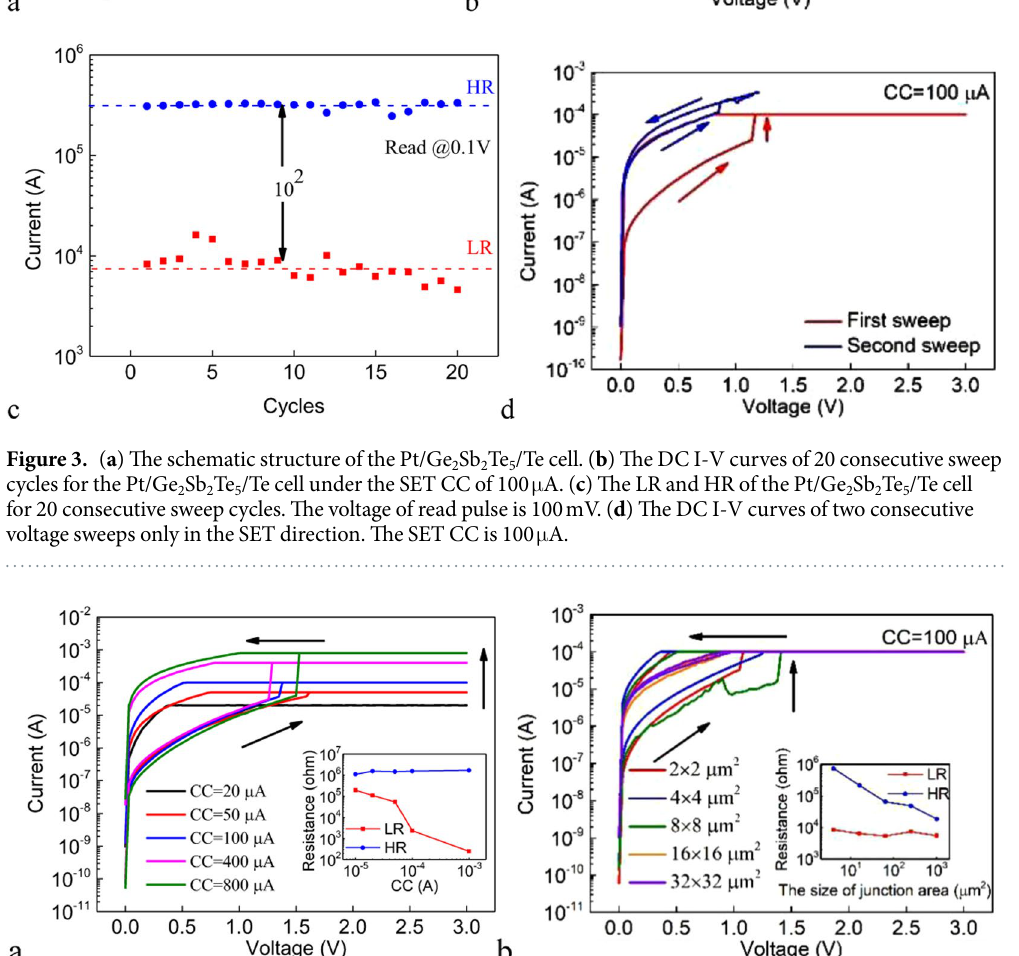
redox reactions occur, leading to the dissolution of Te filament(s) and the restoration of the HR of the cell. It should be pointed out that the thermal effects are not excluded during the switching processes. In particular, conducting paths exist during the initial stage of the RESET process and therefore the local temperature could increase significantly due to the Joule heating effect which facilitates the disconnection of the filament by the diffusion of Te anions into the surroundings under their concentration gradient. The switching mechanisms are schematically shown in Fig. S3. Figure 4(a) shows the DC I-V characteristics for the Pt/Ge 2 Sb 2 Te 5 /Te cell under different SET CCs and the inset shows the dependence of the LR and HR on the CC. The LR decreases with increasing CC due to the for- mation of stronger filament(s). The relationship between the HR and the NSV is also investigated (Fig. S1(c,d)).